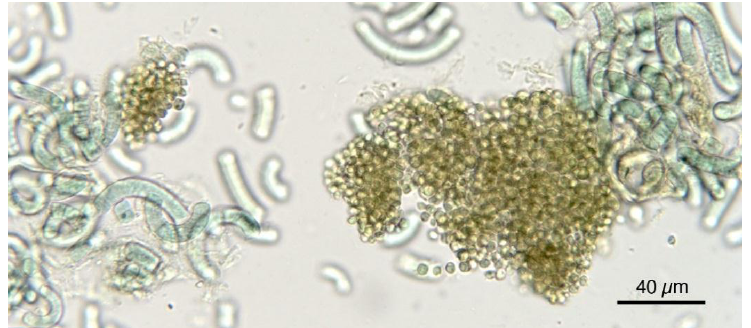
Figure 9. Spirulina product showing the presence of Chlorella -like and/or unicellular cyanobacterial cells.